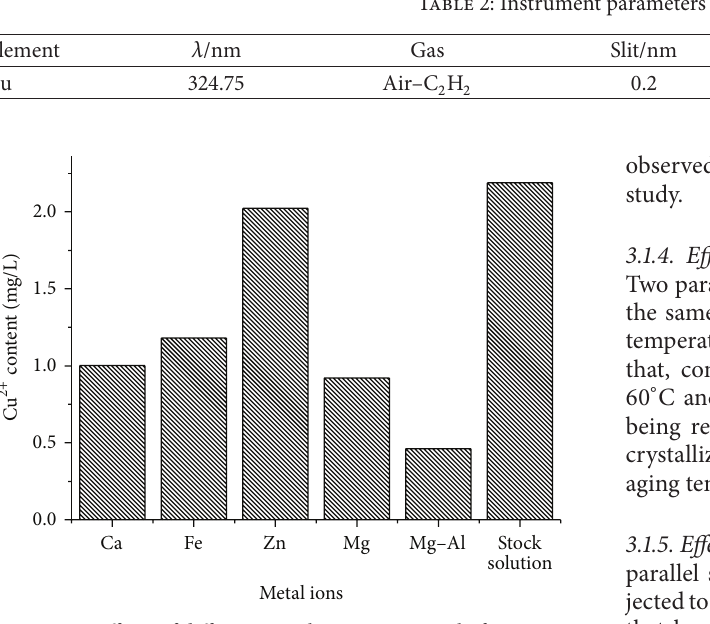
Figure 1: Effects of different metal ions on removal of